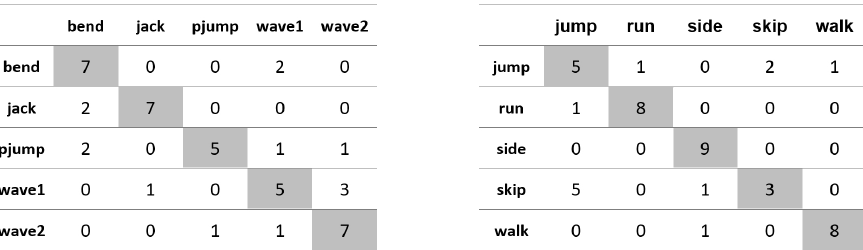
Figure A20. Confusion matrices for the experiment using the ‘upper-occlusion’ database, elongation and Euclidean distance.